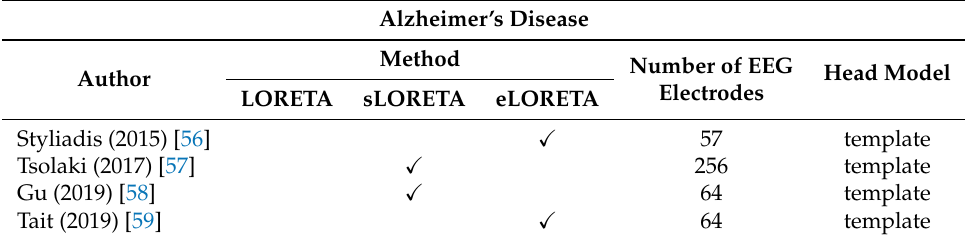
Table 3. Overview of the included papers about Alzheimer’s